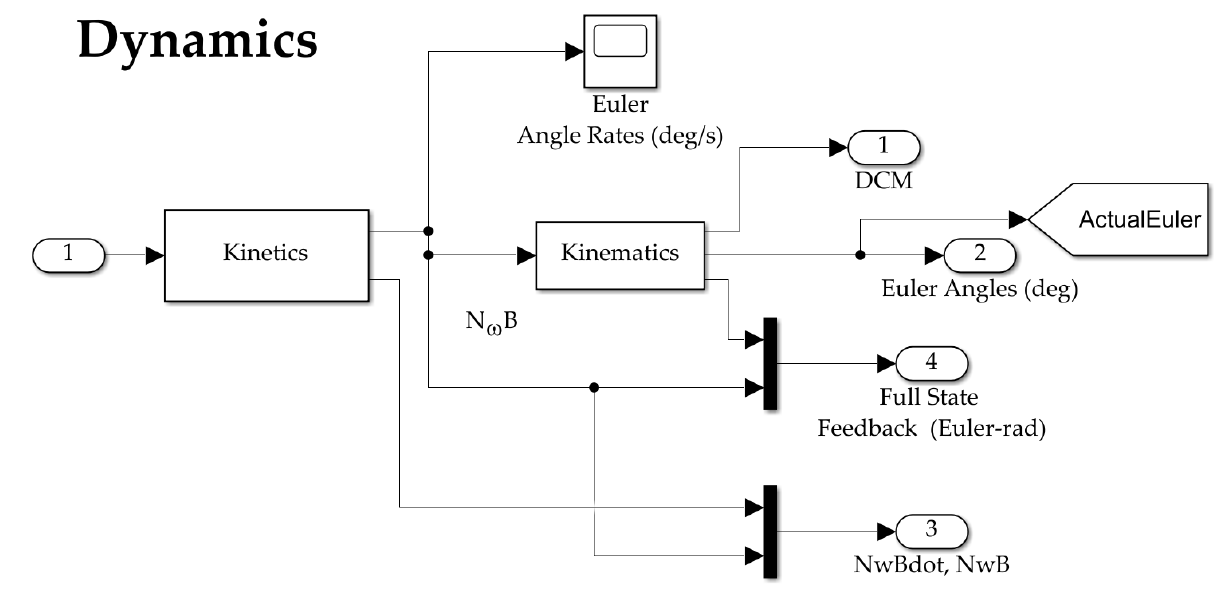
Figure A7. MatLab model with complete detailed Display of the sensors and observers Simulink subsystem.